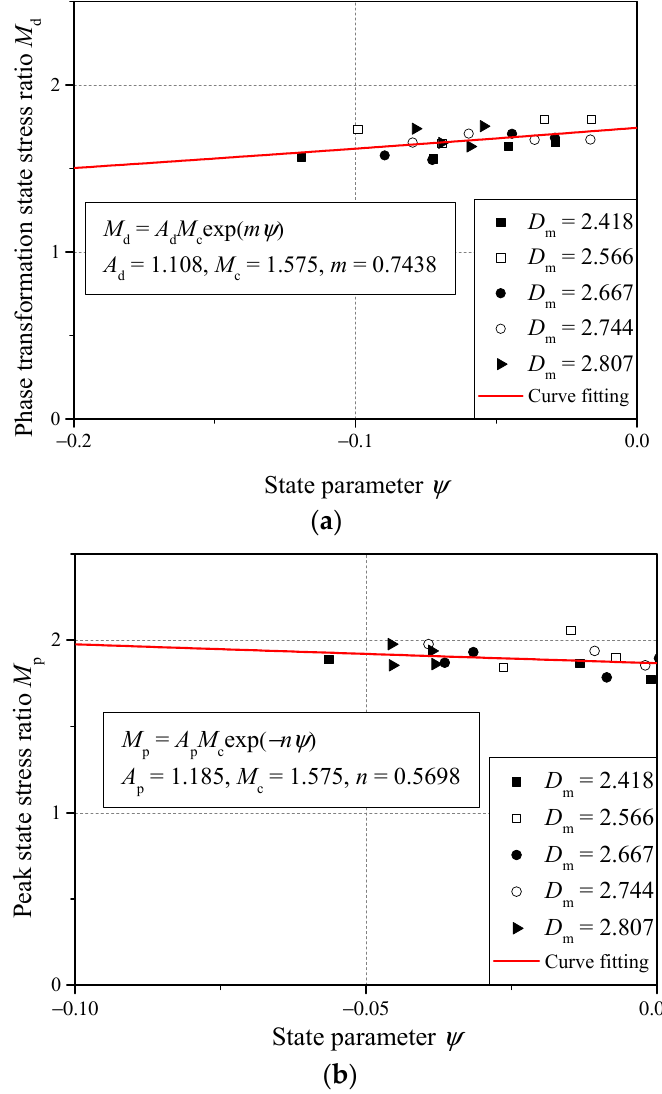
Figure 12. Relationship between state stress ratio and state parameter: ( a ) phase transformation state stress ratio; ( b ) peak state stress ratio.